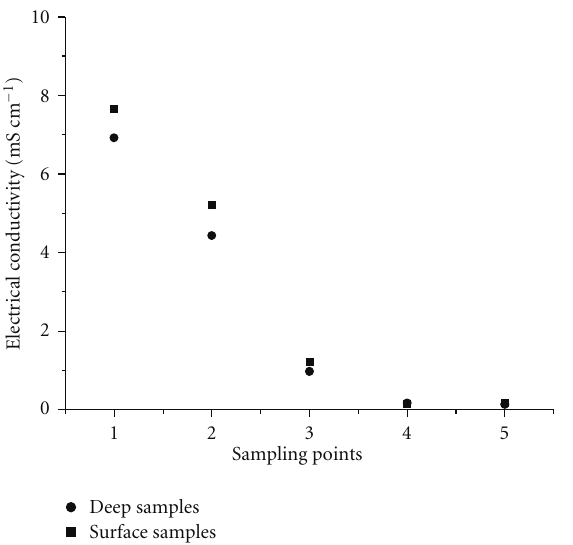
Figure 6: Soluble phosphate concentrations in water samples collected in July of